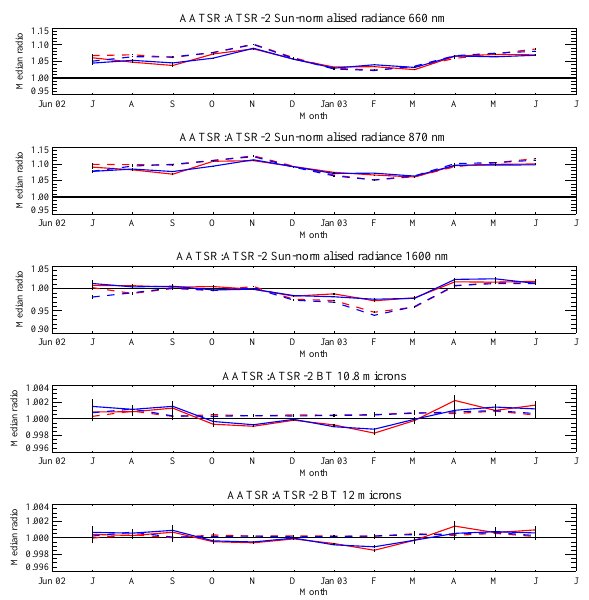
Fig. 4. Variability of the median ratio betweeen AATSR and ATSR-2 measurements (Sun-normalised radiance or brightness temperature, as appropriate) for quality controlled and colocated cloud retrievals during the 2002–2003 overlap year. Results are shown for (from top-bottom) 660nm, 870nm, 1.6µm, 10.8µm, and 12µm. Solid lines indicate land, and dashed lines ocean. Red lines indicate the Northern Hemisphere, and blue the southern. Error bars show the standard error.